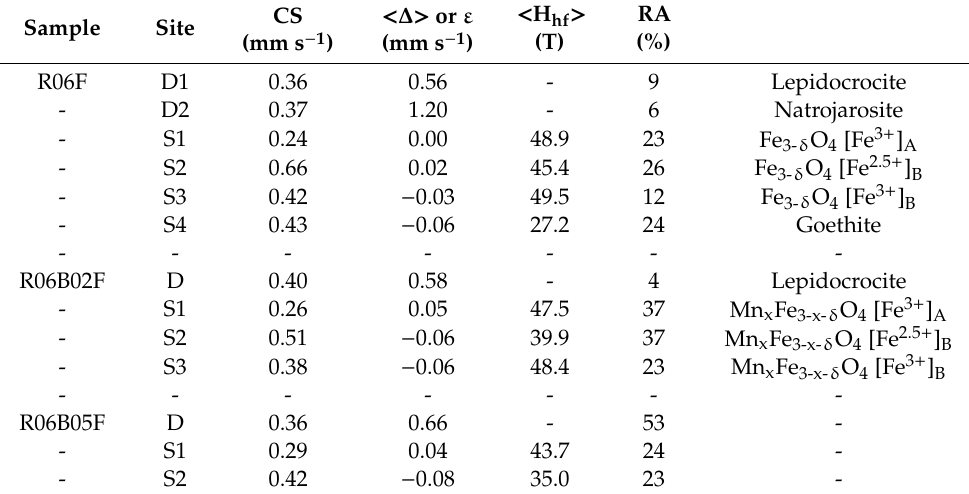
Table 2. Mössbauer hyperfine parameters for the spectra of R06, R06B02 and R06B05 recorded at room temperature (see Figure